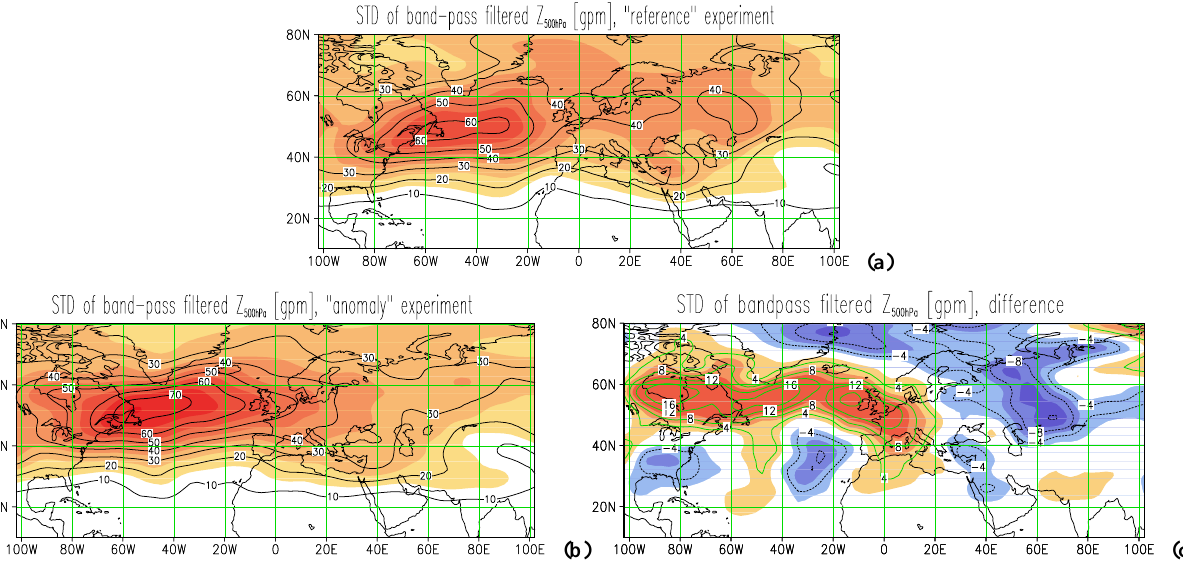
Fig. 8. Storm track variability at the 500 hPa layer. Storm track variability at the 500 hPa layer for mean January (a) Variance of the band- pass filtered (2–6 days) geopotential height at the 500 hPa for the “reference” experiment, (b) Same as (a) but for the “anomaly” experiment, (c) Difference between “anomaly” and “reference”